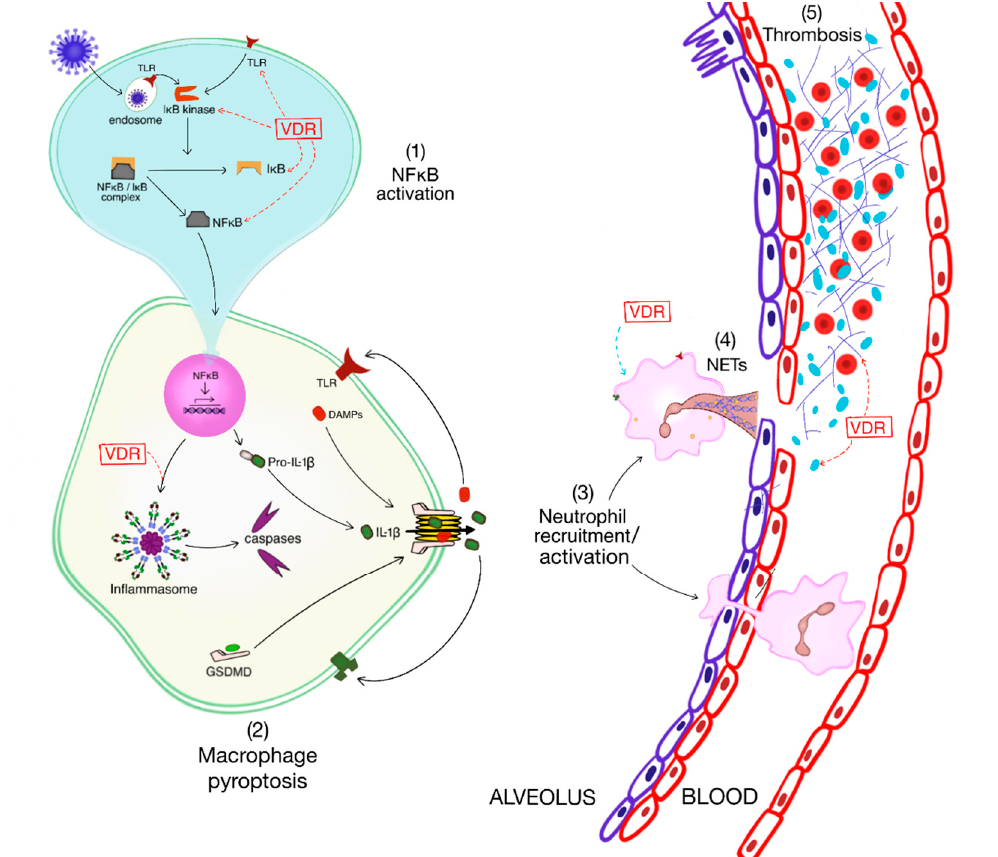
Figure 1. Impact of vitamin D/VDR signaling at various junctures of lung-centric inflammation and immunothrombosis. Experimentally verified inhibitory pathways are indicated with red dashed arrows while an ambiguous pathway is indicated with a blue dashed arrow. As addressed in the text, VDR signaling inhibits the response of alveolar macrophages to viral infection at the level of (1) NF κ B signaling and (2) inflammasome activation, thereby preventing neutrophil recruitment and activation (3). The impact of VDR signaling on NET generation (4) may be context-dependent; VDR can promote or inhibit NETs. VDR signaling inhibits thrombosis (5) by interfering with platelet function and fibrin generation. VDR: Vitamin D Receptor; NETs: Neutrophil Extracellular Traps.